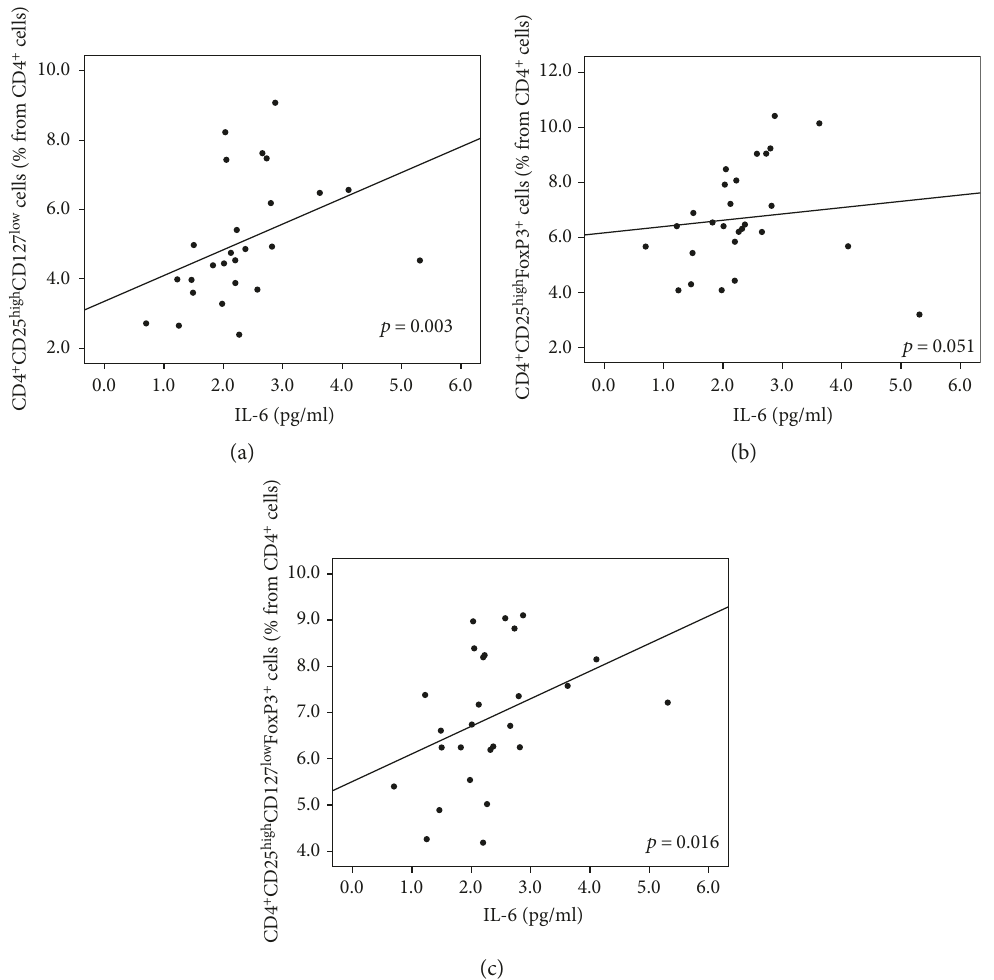
Figure 10: (a – c) T regulatory cells and IL-6. Higher Treg cell count correlated with higher level of proin fl ammatory cytokine IL-6. This relationship reached signi fi cance in the case of CD127 low Treg cells ( p = 0 003 , R = 0 551 ) and CD127 low FoxP3 + Treg cells ( p = 0 016 , R = 0 458 ). The same trend with a borderline signi fi cance was observed for FoxP3 + Treg cells ( p = 0 051 , R = 0 379 ). (a) CD127 low Treg cells (% from CD4 + cells). (b) FoxP3 + Treg cells (% from CD4 + cells). (c) CD127 low FoxP3 + Treg cells (% from CD4 +